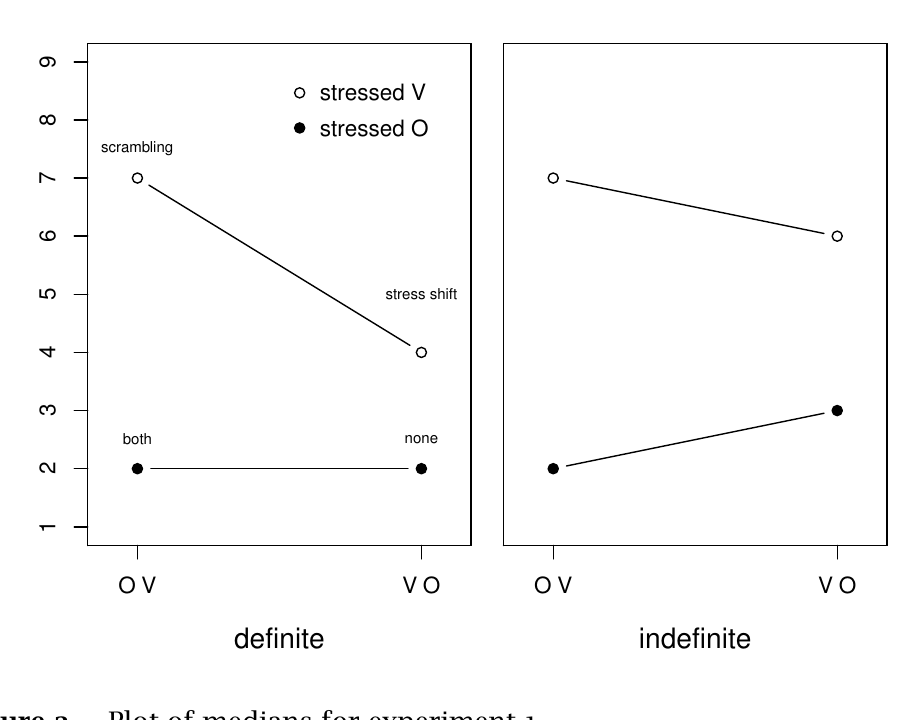
Figure 3 Plot of medians for experiment